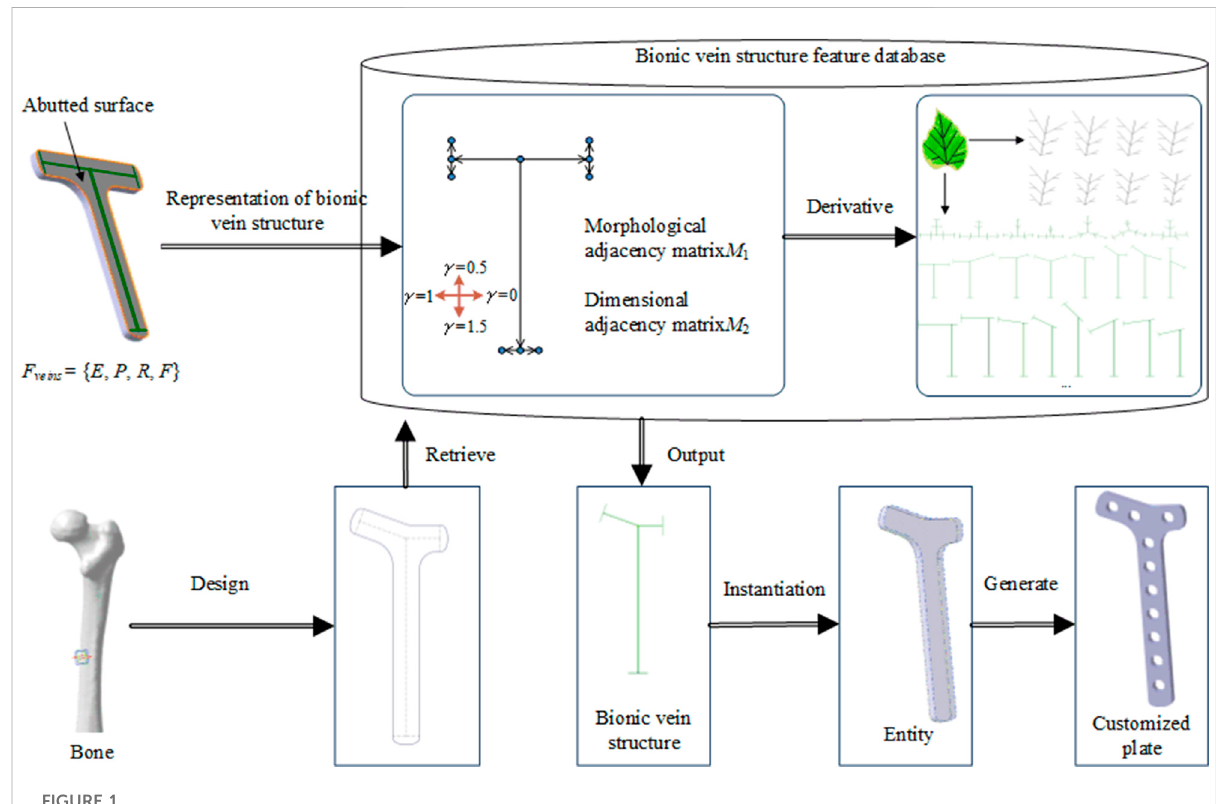
FIGURE 1 Flowchart of the proposed design